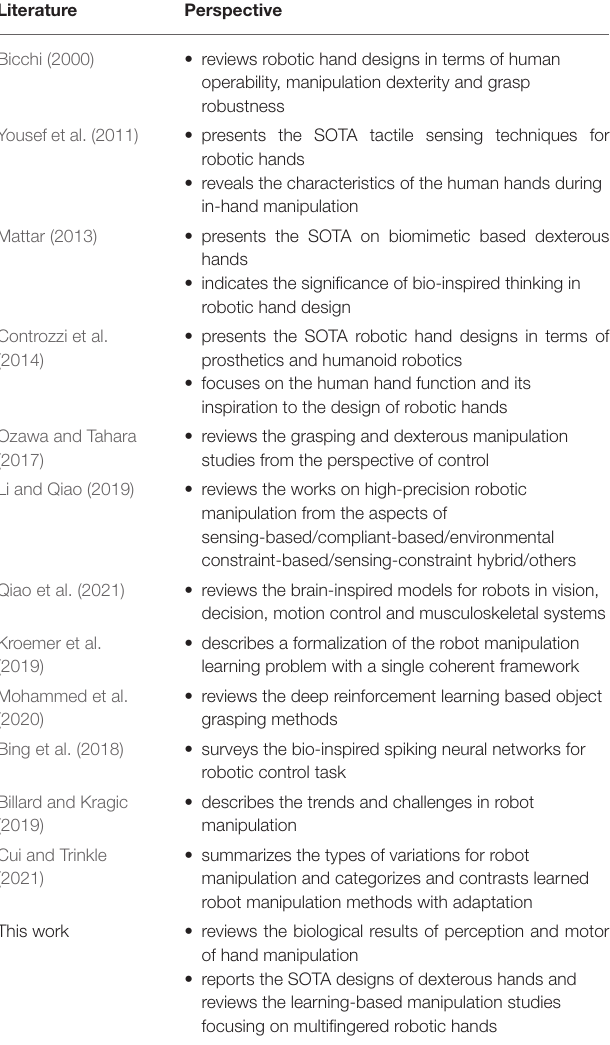
TABLE 1 | Comparisons of the existing